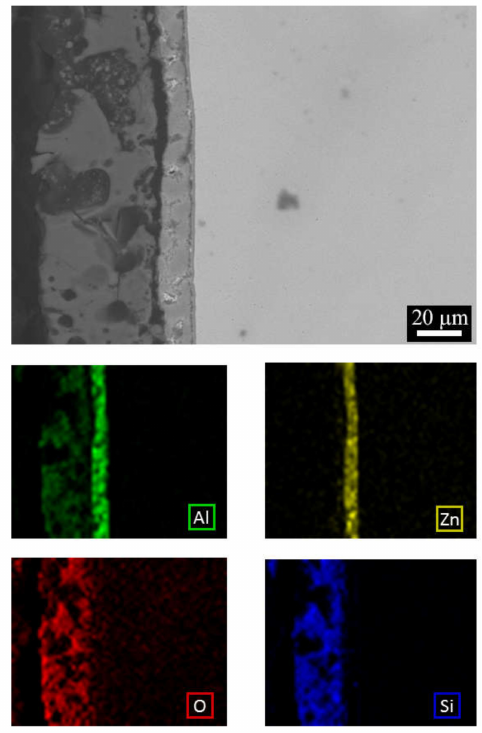
Figure 3. SEM-EDS elemental mapping performed on the cross section of the sample obtained at 2.3 A / cm 2 for 2 min.